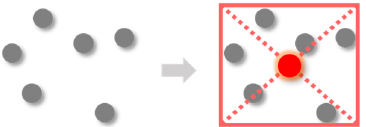
Figure 5. Generating a center point representing an indoor location from multiple indoor points using a minimum bounding box.